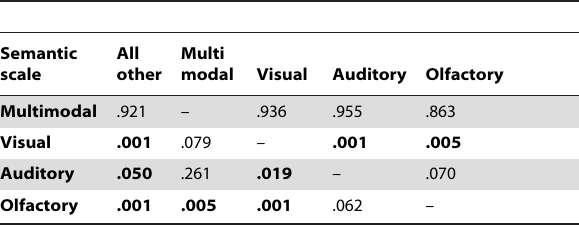
P-values # .05 are highlighted in boldface. Note . The rows represent data from the four semantics scales (multimodal, visual, auditory, olfactory) respectively contrasted to the three other conditions. See the text for details of how to calculate the semantic scales. Each cell represents the p -values as calculated from t-tests. The first column compares one condition with three other conditions; the last four columns are pairwise comparisons between conditions. P -values were not corrected for multiple comparisons. Notice that the results are not symmetrical because each row represents different scales, thus, the olfactory value on the visual scale (row 2, column 6) differs from the visual value on the olfactory scale (row 4, column 4).